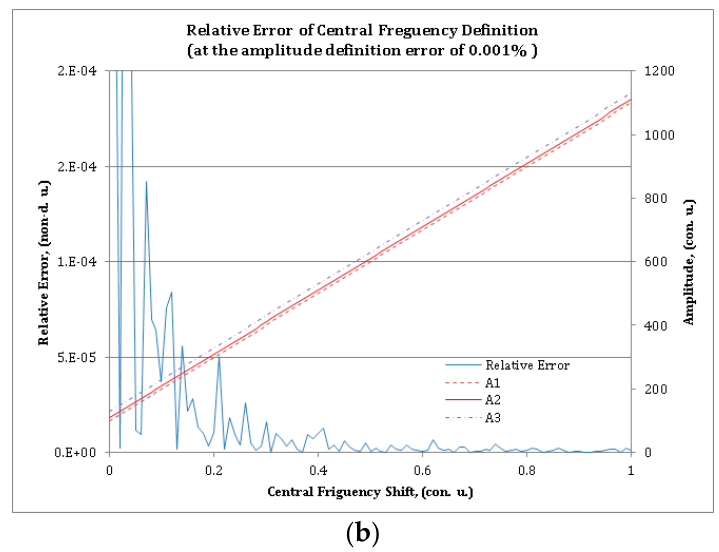
Figure 4. Relative error of the MAFBS central frequency definition for the amplitude definition error of ( a ) 0.01% and ( b ) 0.001%: The thick line is the relative error; the thin lines are the calculated amplitudes of the frequency components.